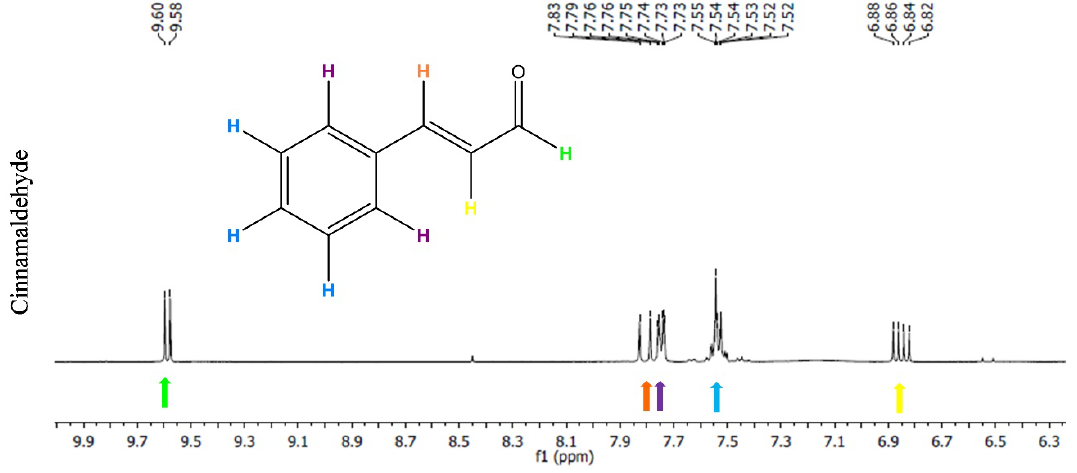
Figure 7. 1 H NMR spectra of cinnamaldehyde (top), a mixture of CTAB-cinnamaldehyde-EDTA in water (middle), and the formulation (bottom). All the solutions were prepared in deuterated water. 3. Discussion Inefficient cleaning and disinfection will contribute to surface contamination and microbial spreading, which, overall, may impact on the infection rate [8,35]. There are many protocols to impart cleaning or disinfectant formulations on surfaces, but the majority use some form of wiping [34,36].